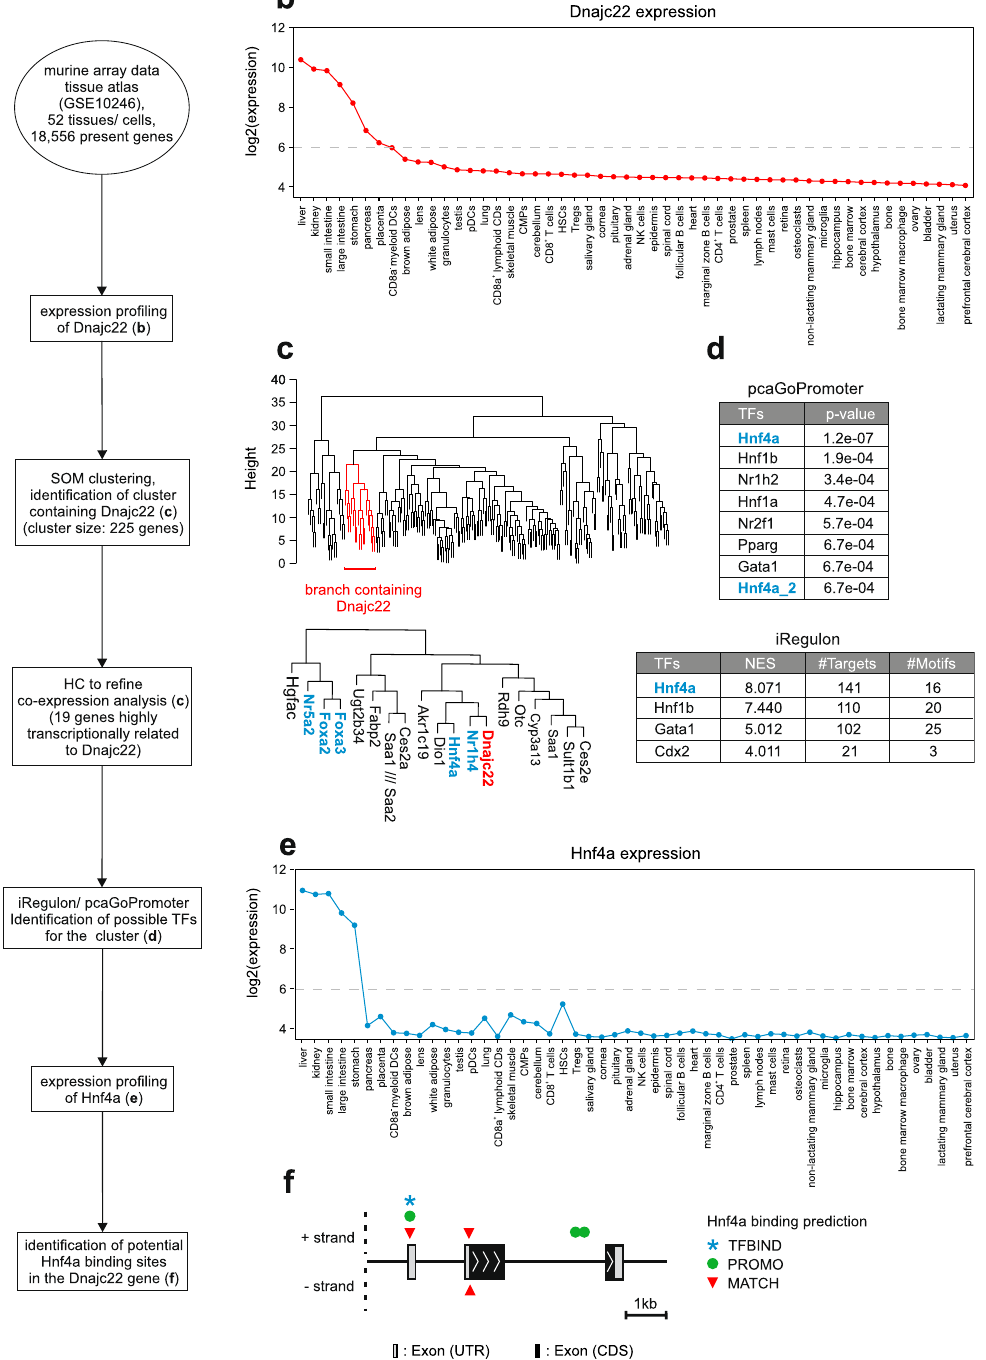
Figure 1. Identification of Hnf4a as a potential transcriptional regulator of Dnajc22. ( a ) Schematic workflow for the in silico analyses to identify potential transcriptional regulators of Dnajc22 expression (TF = transcription factor, HC = hierarchical clustering, SOM = self-organizing map). ( b ) Expression profile of murine Dnajc22. ( c ) Hierarchical clustering of genes which were grouped together according to self-organizing maps. Subcluster containing genes which were found to be highly transcriptionally related to Dnajc22 is highlighted in red. Transcription factors among those are marked in blue. ( d ) Potential TFs regulating genes contained in the Dnajc22-associated SOM-cluster identified by either iRegulon or pcaGoPromoter. TFs that are included in the SOM-cluster ( c ) themselves are marked in blue (TFs = transcription factors, NES = motif enrichment score). ( e ) Expression profile of Hnf4a. ( f ) Schematic representation of the murine Dnajc22 promoter region including possible Hnf4a binding sites predicted by TFBIND, PROMO, or MATCH. (UTR = untranslated region, CDS = coding